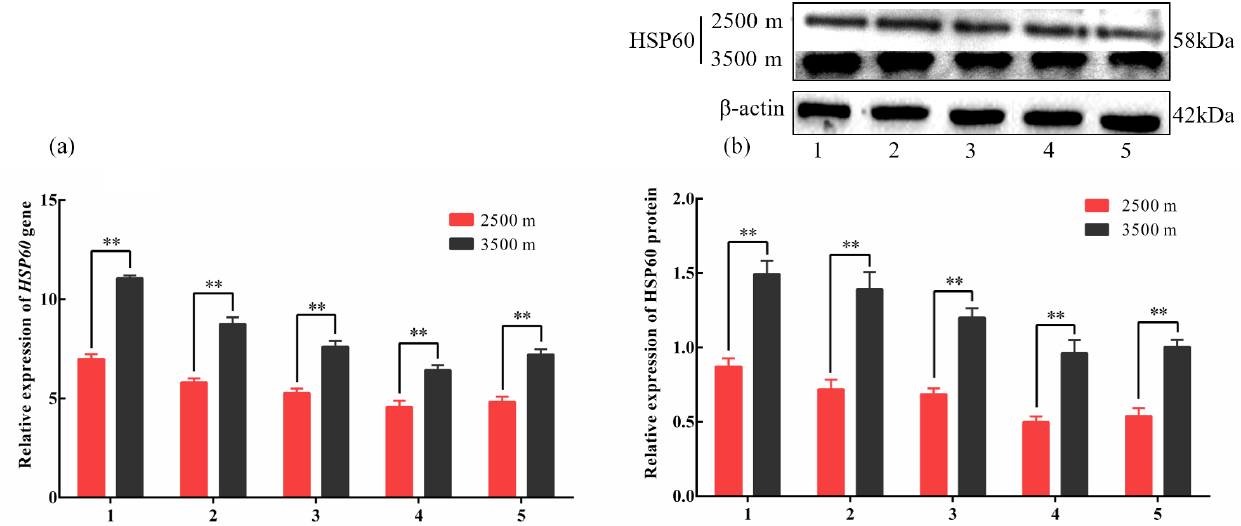
Figure 4. The expression levels of HSP60 mRNA (a) and protein (b) levels in various tissues obtained from yak living at different altitudes. Note that heart (1), liver (2), lung (3), kidney (4), and longissimus dorsi (5) tissue homogenates were analyzed for mRNA (a) and protein expression (b) . The expression values for the qPCR and western blot are given relative to the expression levels of the β -actin , GAPDH , and RPL19 gene and β -actin protein. The bars represent the mean ± SEM from three independent biological replicates, performed with three (a) or eight (b) technical replicates. Asterisks denote significant differences: * P < 0 . 05; ** P < 0 . 01